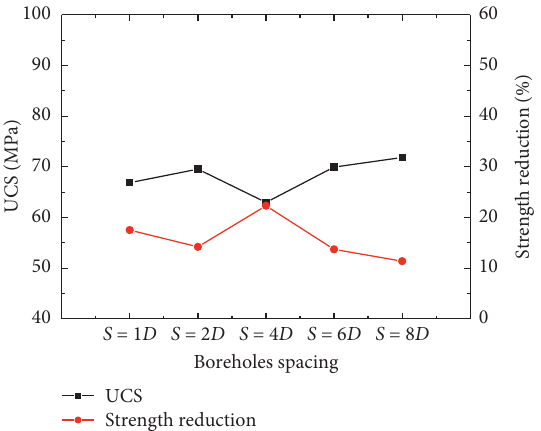
Figure 11: Strength reduction curves of rock samples with different boreholes spacing.